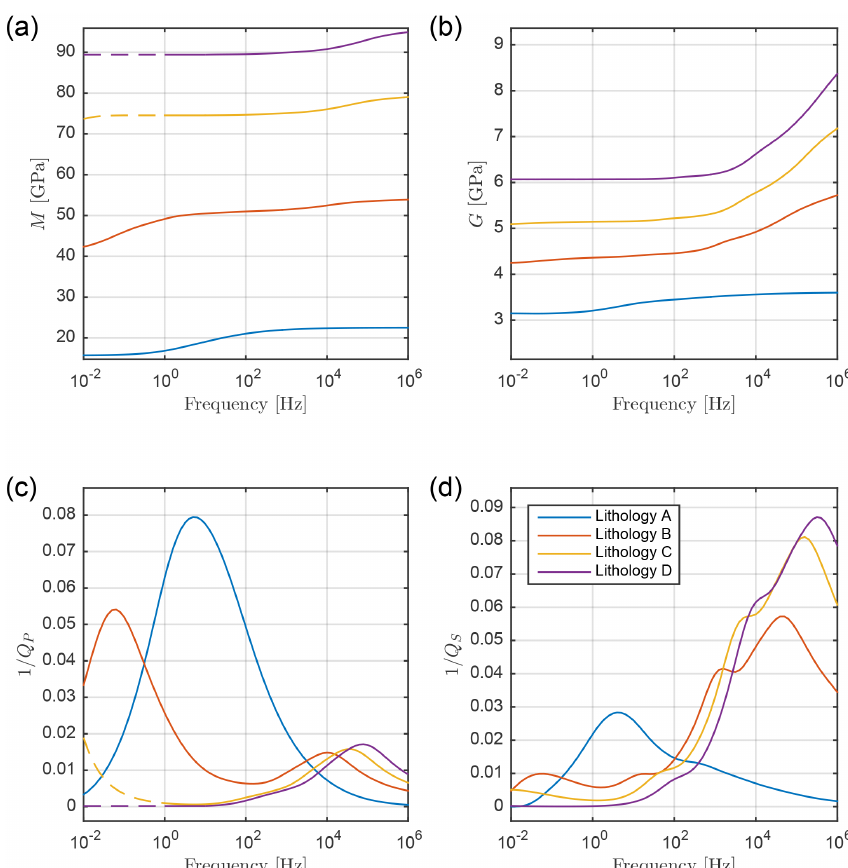
Figure 14. P-wave modulus (a) , S-wave modulus (b) , inverse P-wave quality factor (c) , and inverse S-wave quality factor (d) for the four lithology cases A–D, all modeled for a lithostatic stress of 15MPa. The red curves are identical to those in Fig. 11. The dashed parts of the graphs indicate the low-frequency ranges, at which the numerical solution breaks down due to the very low permeability and porosity of the corresponding